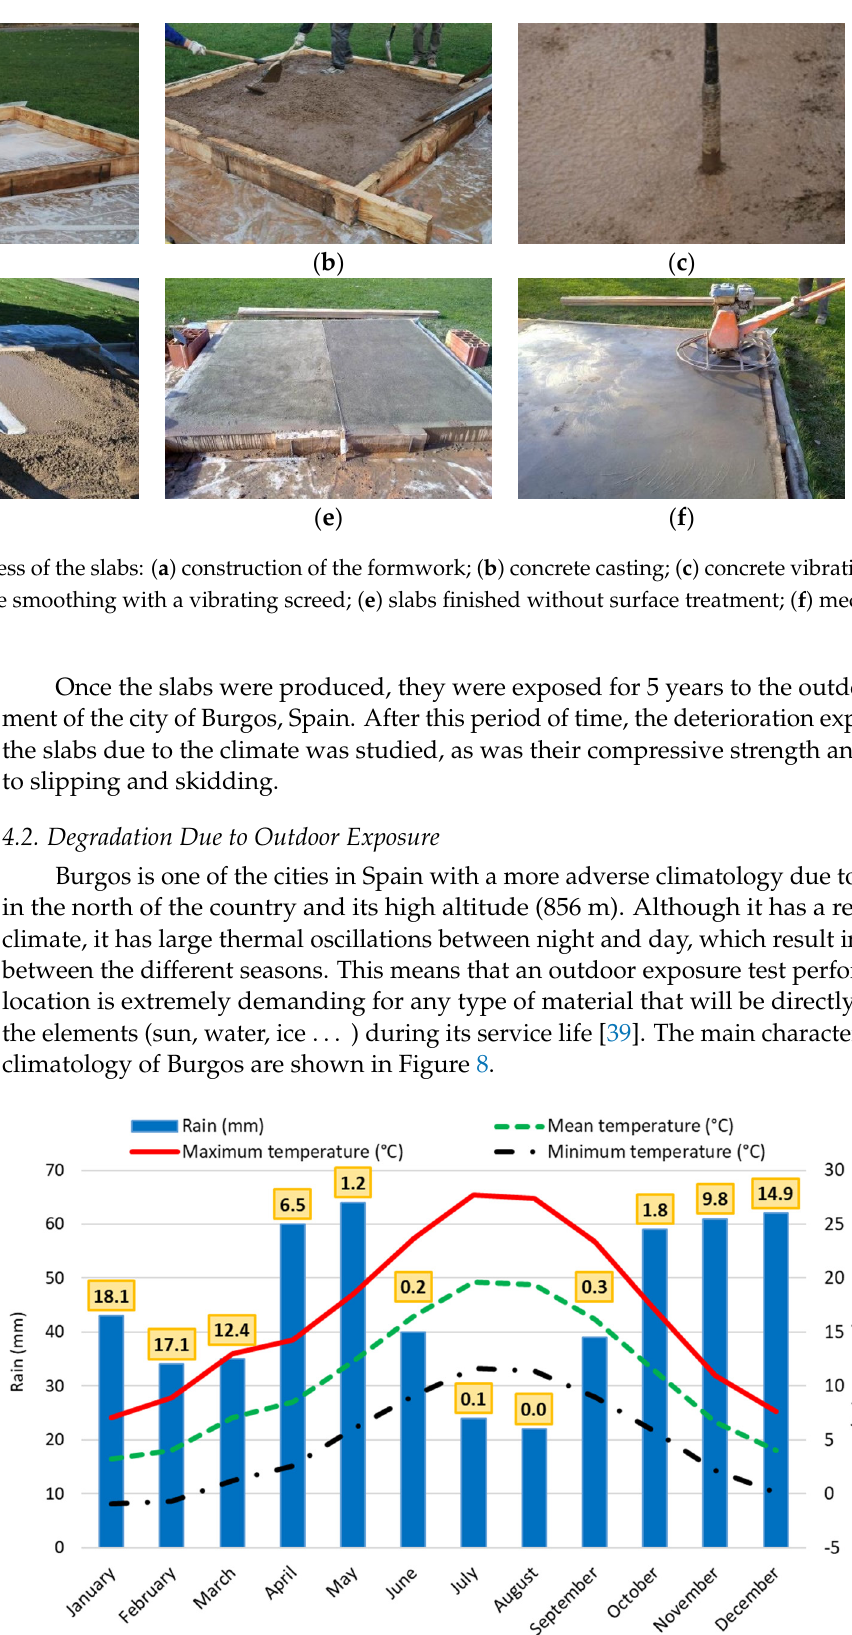
( a ) ( b ) Figure 9. Surface-treatment defects: ( a ) cracks (SAC-mix slab); ( b ) chips (SAC/Y-mix slab) (adapted from [23]). 4.3. Compressive Strength: Core Drilling After five years of exposure to the outdoor environment, three 75 × 150- mm cores (height-to-diameter ratio equal to 2) were extracted from each slab to evaluate the devel- opment of compressive strength (EN 12390-3 [30]) under real conditions (large volume of concrete manufactured and no storage in a wet chamber). The results obtained are shown in Table 8. Table 8. Compressive strength on 75 × 150 mm cores (mean value and standard deviation). Mix Compressive Strength (MPa) SAC 70.2 ± 2.3 SAC/M 76.4 ± 2.8 SAC/Y 69.6 ± 2.1 The values of compressive strength obtained show that the slabs exhibited the same behavior as that observed in lab specimens (Figure 6): the mix with the highest compres- sive strength was the SAC/M mix, while the SAC mix showed the second highest value. The SAC/Y mix had the lowest compressive strength, although the difference with the compressive strength of the SAC mix was only 0.6 MPa. This non-significant difference between the compressive strength of SAC and SAC/Y mixes supports the previously